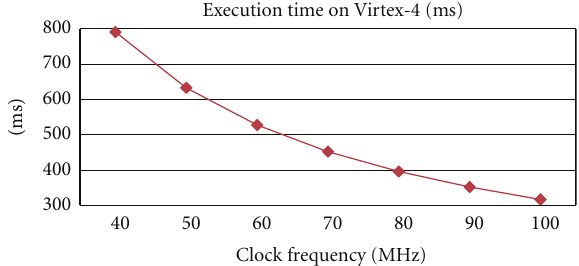
Figure 16: Impact of the clock frequency to the execution time of a uniprocessor design on a V4FX100.